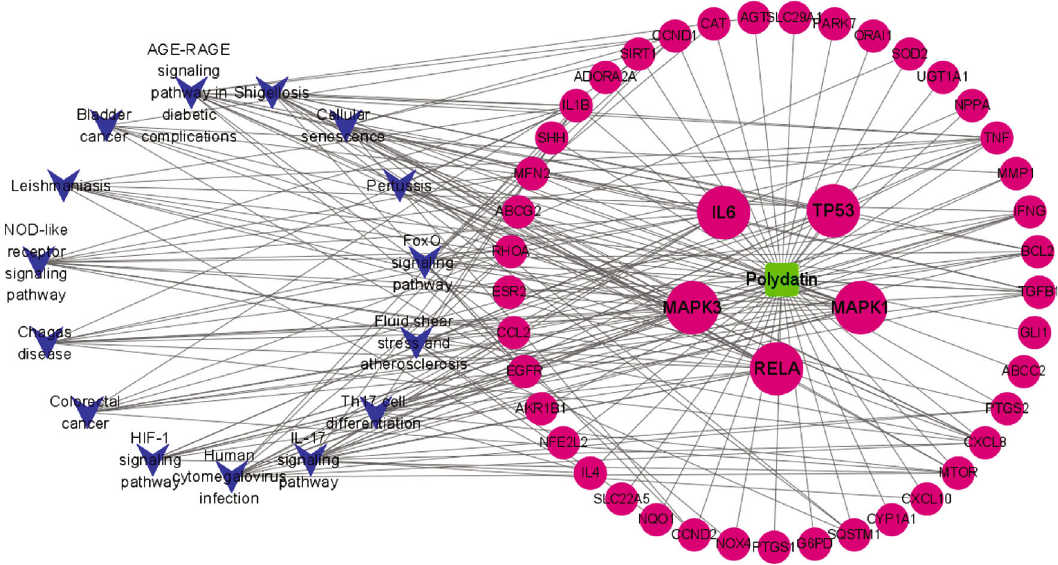
Figure 5: Targets-pathways network of polydatin. Green node represents compound, red nodes represent 46 intersection targets, and blue nodes represent top 15 KEGG signaling